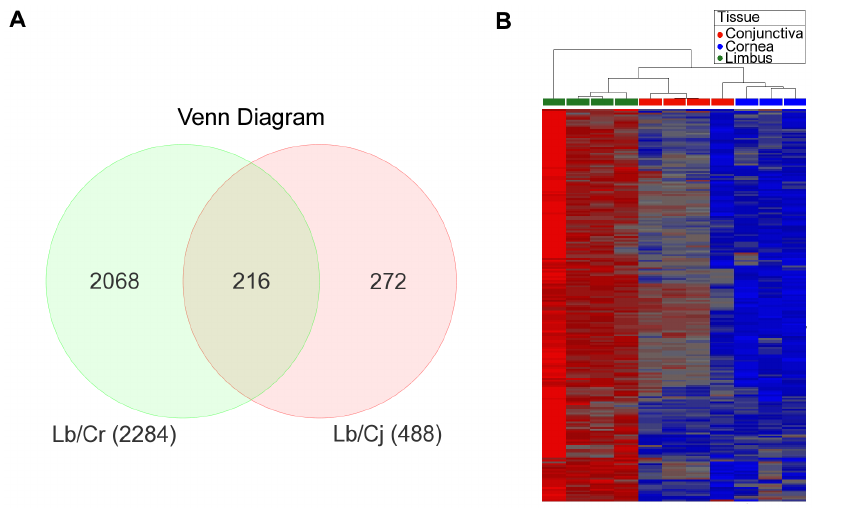
Figure 2. Analysis of preferential transcription in the limbus compared to the cornea and conjunctiva. A) Venn diagram of 216 preferentially expressed limbal transcripts (including unknown and overlapping probes) between the limbal over corneal and conjunctival transcripts. B) Heat map of the 216 preferentially expressed limbal transcripts (including unknown and overlapping probes) between the limbal over corneal and conjunctival transcripts categorized by anatomical tissue. Red signifies overexpression and blue signifies underexpression.